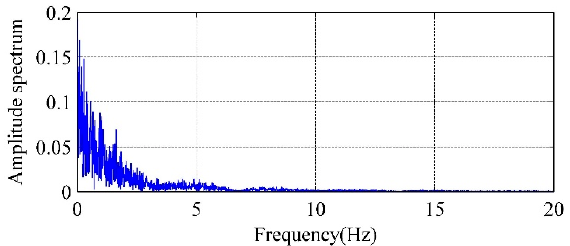
Figure 18. Amplitude spectrum of the longitudinal flow velocity of 3# crest overflowing orifice outlet.